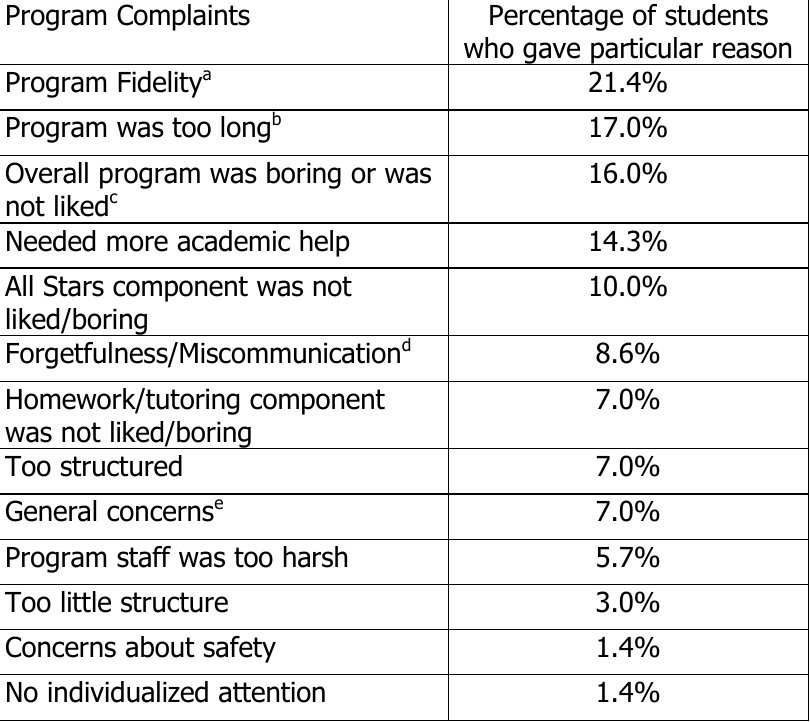
Reasons for Non-Attendance: Internal Issues,